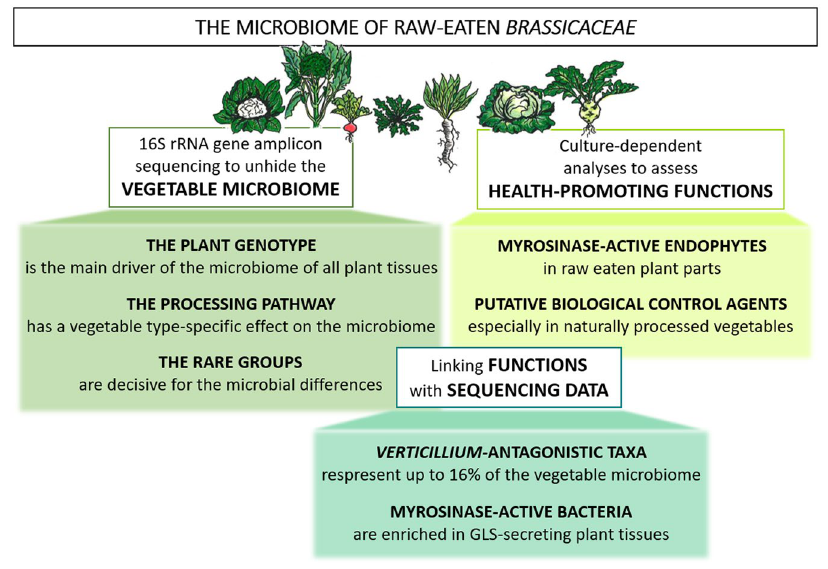
Figure 6. Overview of the present study investigating the microbiome of raw-eaten Brassicaceae . The composition and the crucial drivers of the vegetable microbiomes were determined using cultivation- independent 16S rRNA gene amplicon sequencing. Cultivation-dependent approach was performed to isolate bacteria from vegetables that execute specific health-promoting functions: myrosinase activity proving potential anti-cancer effects in humans and antagonistic activity towards V. longisporum . Additionally, in order to locate bacterial myrosinase genes in different parts of Brassica plants, the metagenomes of E. sativa´s and B. napus´ phyllosphere, rhizosphere and bulk soil were